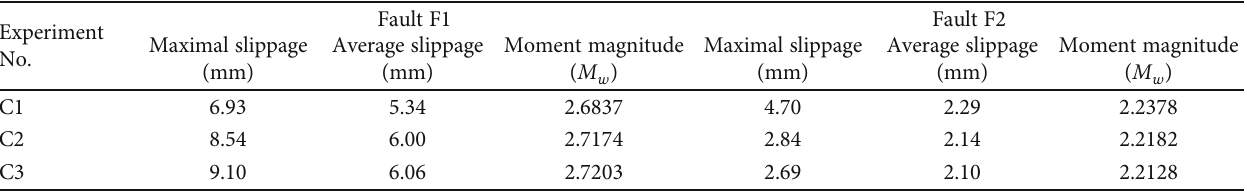
Table 4: The induced slippage and moment magnitude under di ff erent fracturing patterns of faults F1 and F2 (Experiment Nos. H1-H3). Experiment No.